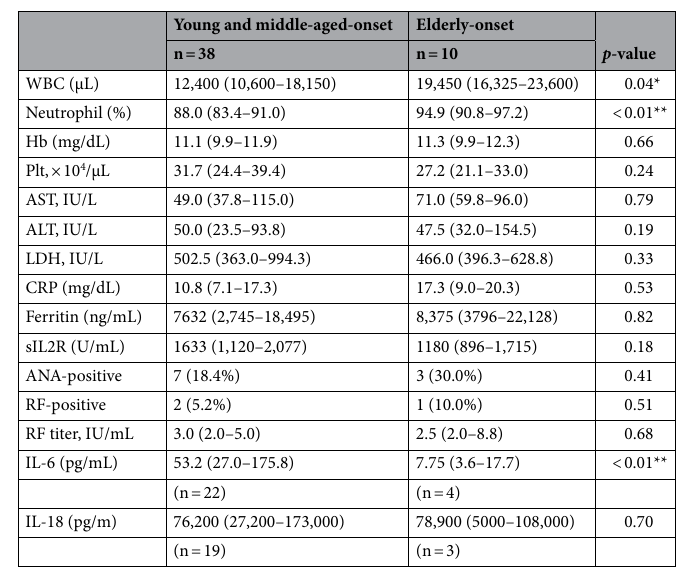
Table 2. Comparison of the laboratory data and cytokine profiles of the young and middle-aged-onset and elderly-onset groups. ANA antinuclear antibody. Data represent the median (interquartile range) or numbers of patients. p -value: Fisher exact test for categorical variables and Mann–Whitney U test for continuous variables. *Significant value ( p < 0.05). **Significant value ( p <